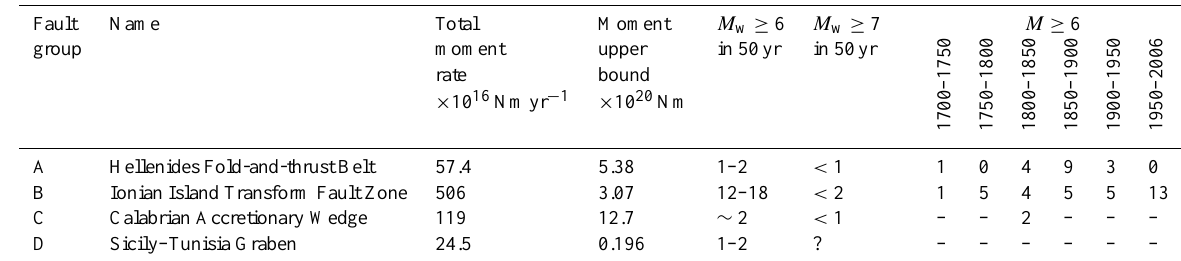
Table 5. Frequency of larger earthquakes for the four groups of crustal fault sources and historically observed seismicity ( M ≥ 6) in 50-yr intervals for the last three